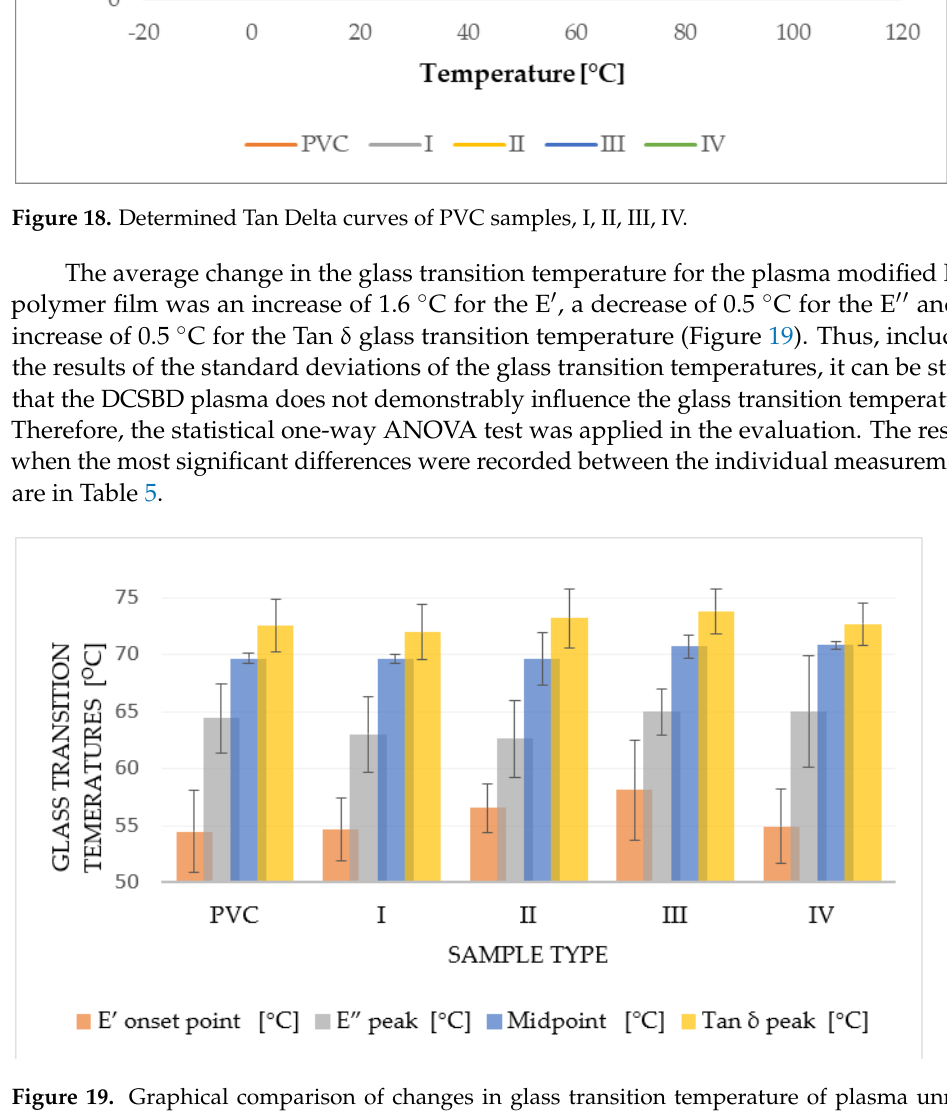
Figure 19. Graphical comparison of changes in glass transition temperature of plasma unmodified PVC and series of plasma modified polymer films PVC (I–IV) for individual modules of dynamic-mechanical analysis E′ and E′′, Tan δ and glass transition temperature obtained from DCS analysis (Midpoint).